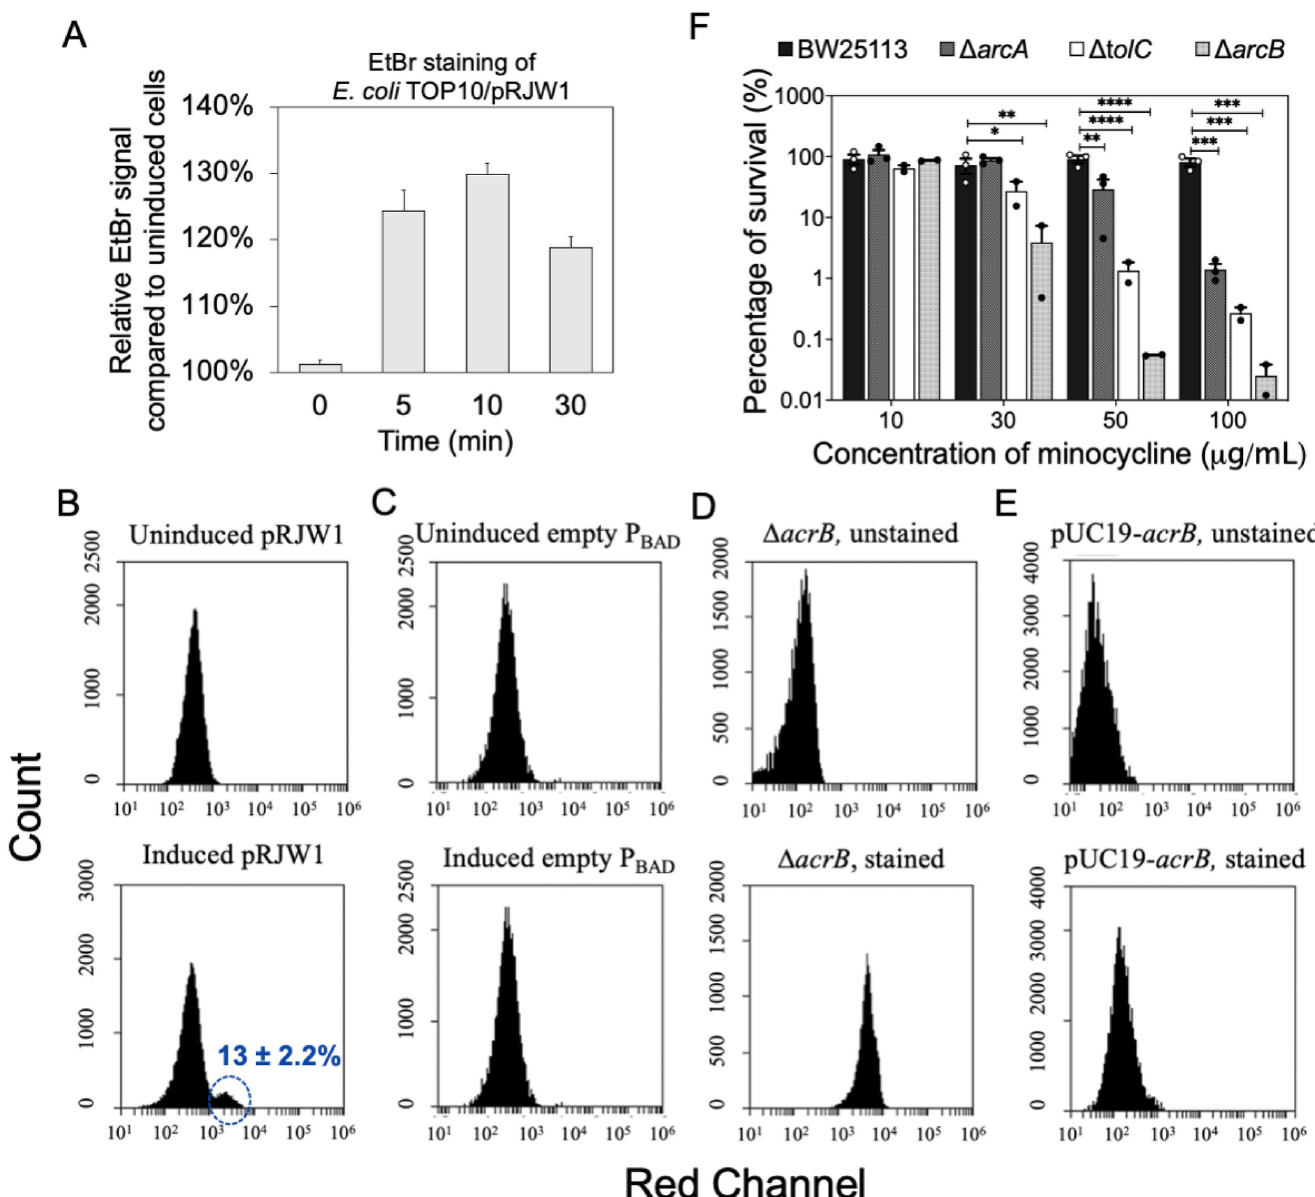
Fig 2. Persister formation led to reduced efflux pump activities. (A) Induction of persister formation led to increased EtBr accumulation. Measurements were performed with a fluorescence microplate reader with excitation at 360 nm. (B-E) Flow cytometry analysis of EtBr staining. (B) EtBr stained uninduced E . coli Top10/ pRJW1 (top) and EtBr stained arabinose induced E . coli Top10/pRJW1 (bottom). Induced E . coli Top10/pRJW1 had 13 ± 2.2% of the population shifted to stronger fluorescence, indicating more EtBr accumulation. (C) EtBr stained uninduced E . coli Top10 pBAD (top) and EtBr-stained arabinose induced E . coli Top10/pBAD (empty vector) (bottom). (D) E . coli Δ acrB without (top) and with (bottom) EtBr staining. (E) E . coli pUC19- acrB without (top) and with (bottom) EtBr staining. (F) Inactivation of efflux pumps sensitized normal cells to minocycline. Means ± SE are shown (n = 3). � p -value � 0.05, �� p -value � 0.01, ��� p -value � 0.001, ���� p - value �